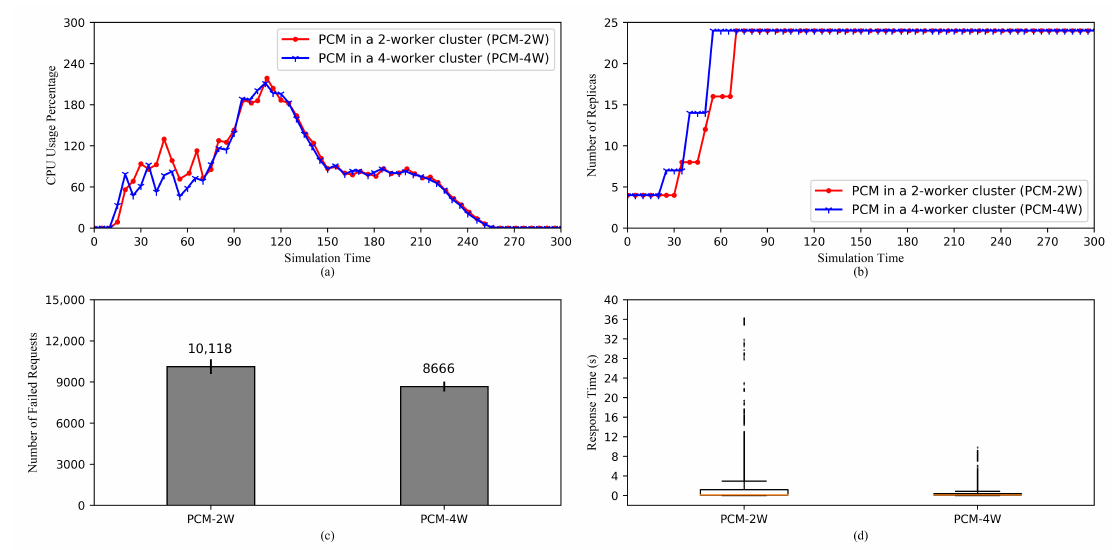
Figure 7. Comparisons of HPA performances in 2-worker and 4-worker clusters. ( a ) The average CPU usage. ( b ) The scaling of the replica set. ( c ) The total number of the failed requests. ( d ) Response time of the successful